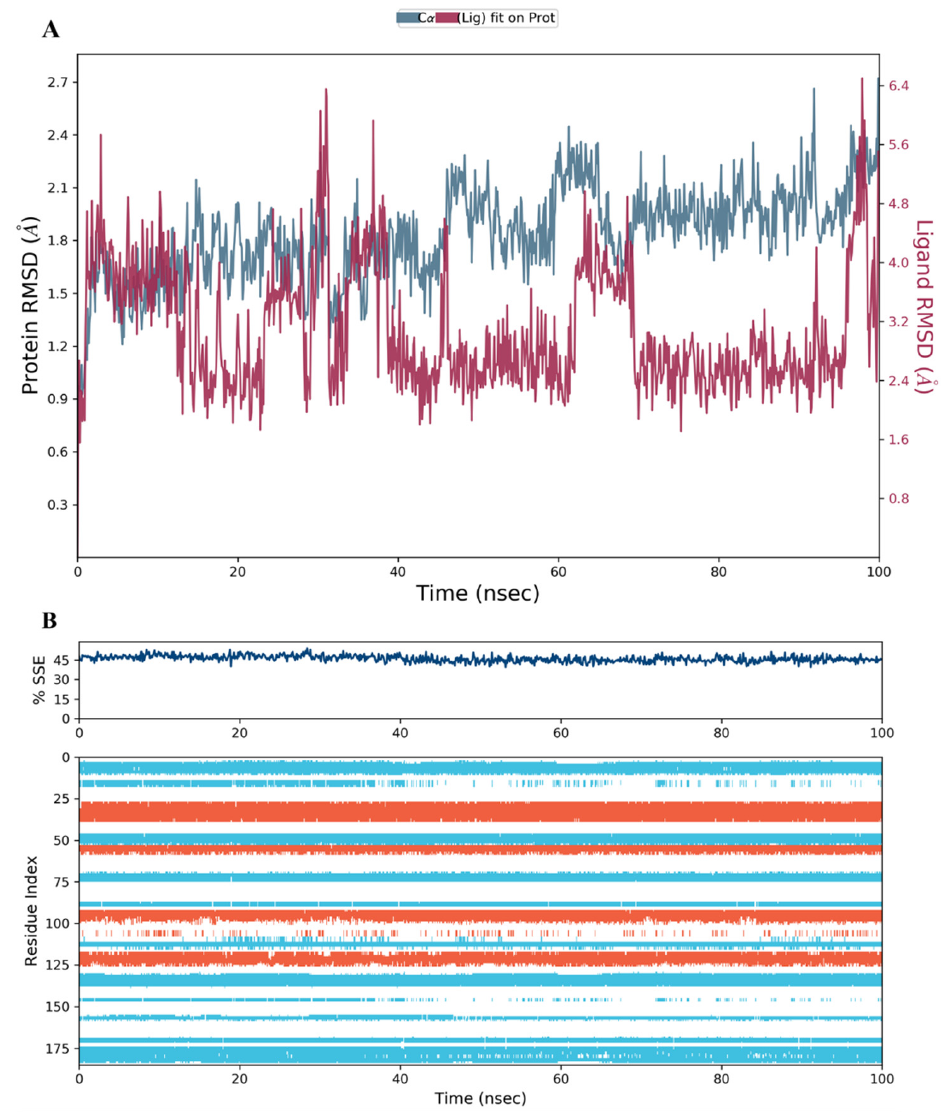
Figure 13. ( A ) The RMSD plot for compound 28 complexed with hDHFR (PDB: 1KMV) over a 100 ns simulation time; ( B ) Stability of the hDHFR secondary structure over 100 ns of MD simulation when complexed with 28 . Protein secondary structure elements (SSE) like alpha-helices (orange color) and beta-strands (light blue color) were monitored during the simulation. The upper plot reported SSE distribution by residue index across the protein structure, and the plot at the bottom monitored each residue and its SSE assignment over the simulation time. The secondary structure elements (SSE), alpha helices in orange and beta strands in light blue, of hDHFR (PDB: 1KMV) complexed with each ligand, were monitored during the 100 ns simulation time. The results showed that the total %SSE was maintained for all ligands and that most of the individual SSEs (by residue index) were stable throughout the run. Minor differences were observed in the turn and loop regions between the reference inhibitor SRI-9662 and the three investigated metabolites (Figures 11, 12B, 13B and 14B), as a few parts of these regions were less stable when each of the metabolites interacted with the